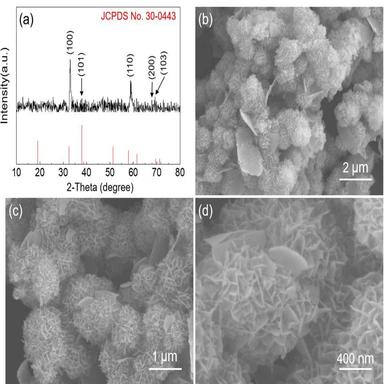
(a) XRD pattern of β-Co(OH)2 microflowers, and (b-d) SEM images of β-phase Co(OH)2 microflowers in different magnifications.